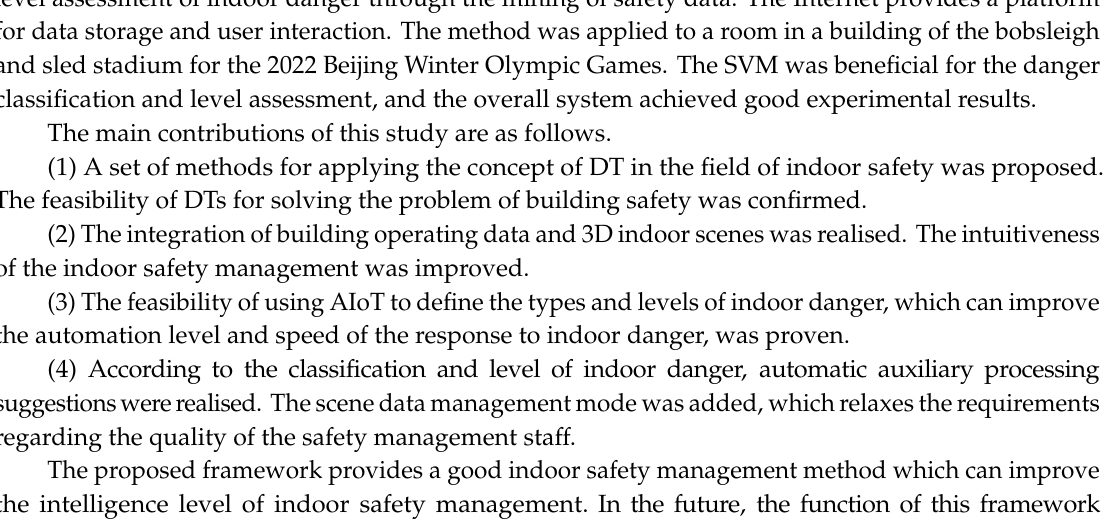
Figure 17. Synchronous alarms in the virtual and real worlds.